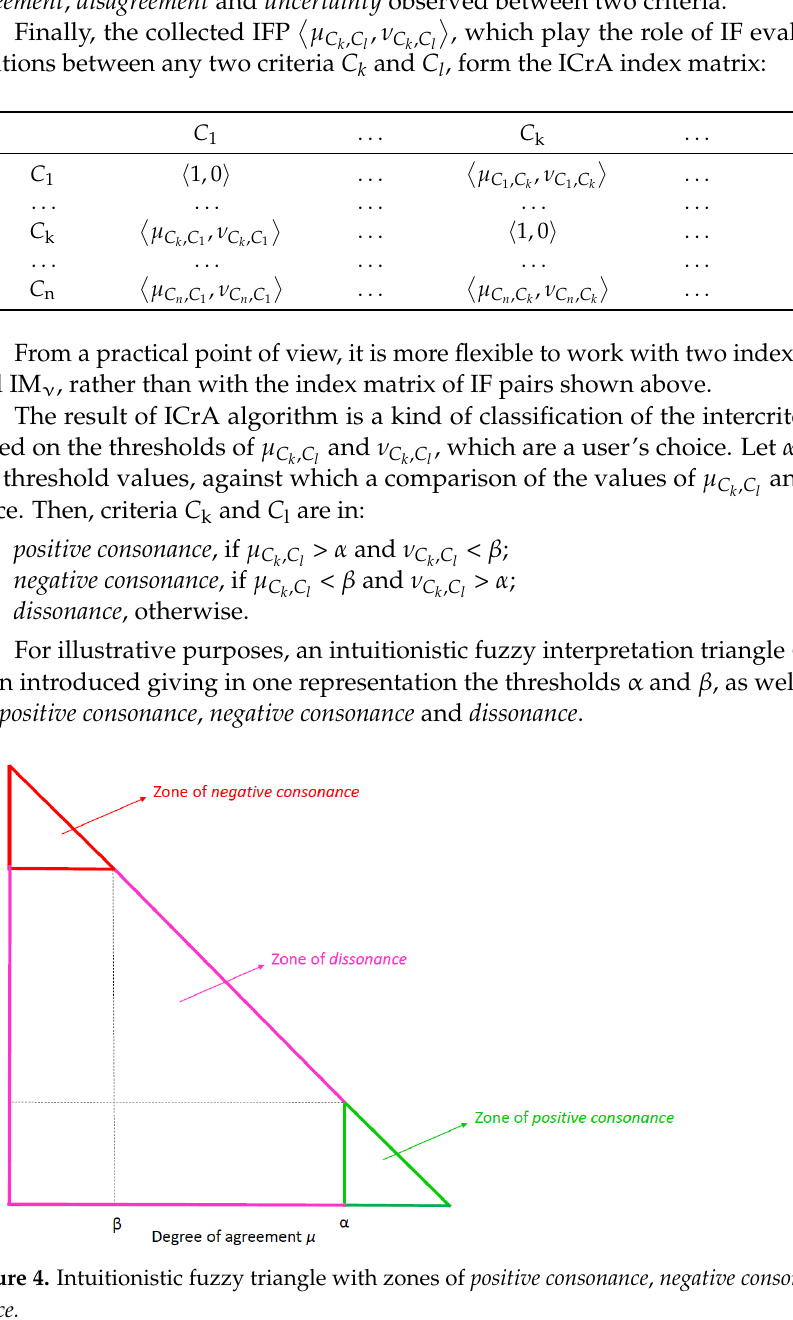
Figure 5. Result of the application of ICrAData v.2.3 over the 88 ECG criteria described in Section 2.1.